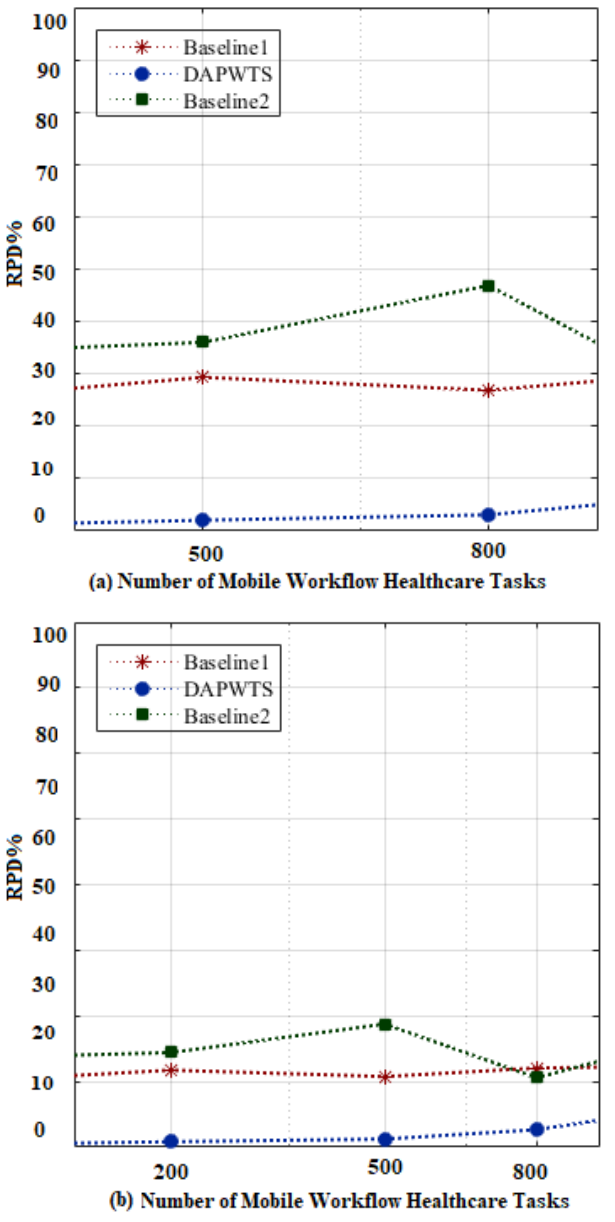
Figure 11. Multiple workflow application failure-aware